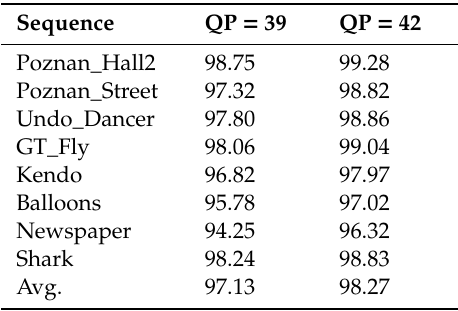
Table 6. Mode decision accuracy of the proposed